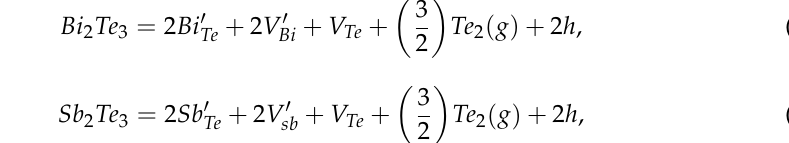
Table 1. X-ray fluorescence (XRF) results of trace elements in Bi 0 . 5 Sb 1 . 5 Te 3 powder and bulk samples.